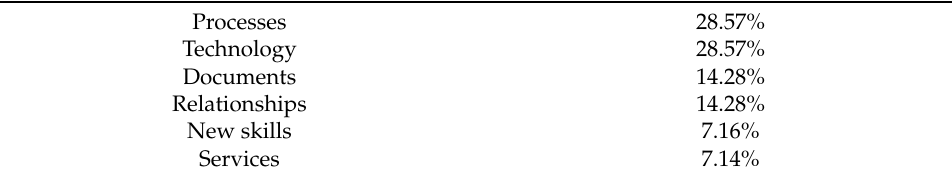
Table 3. Processes of digital